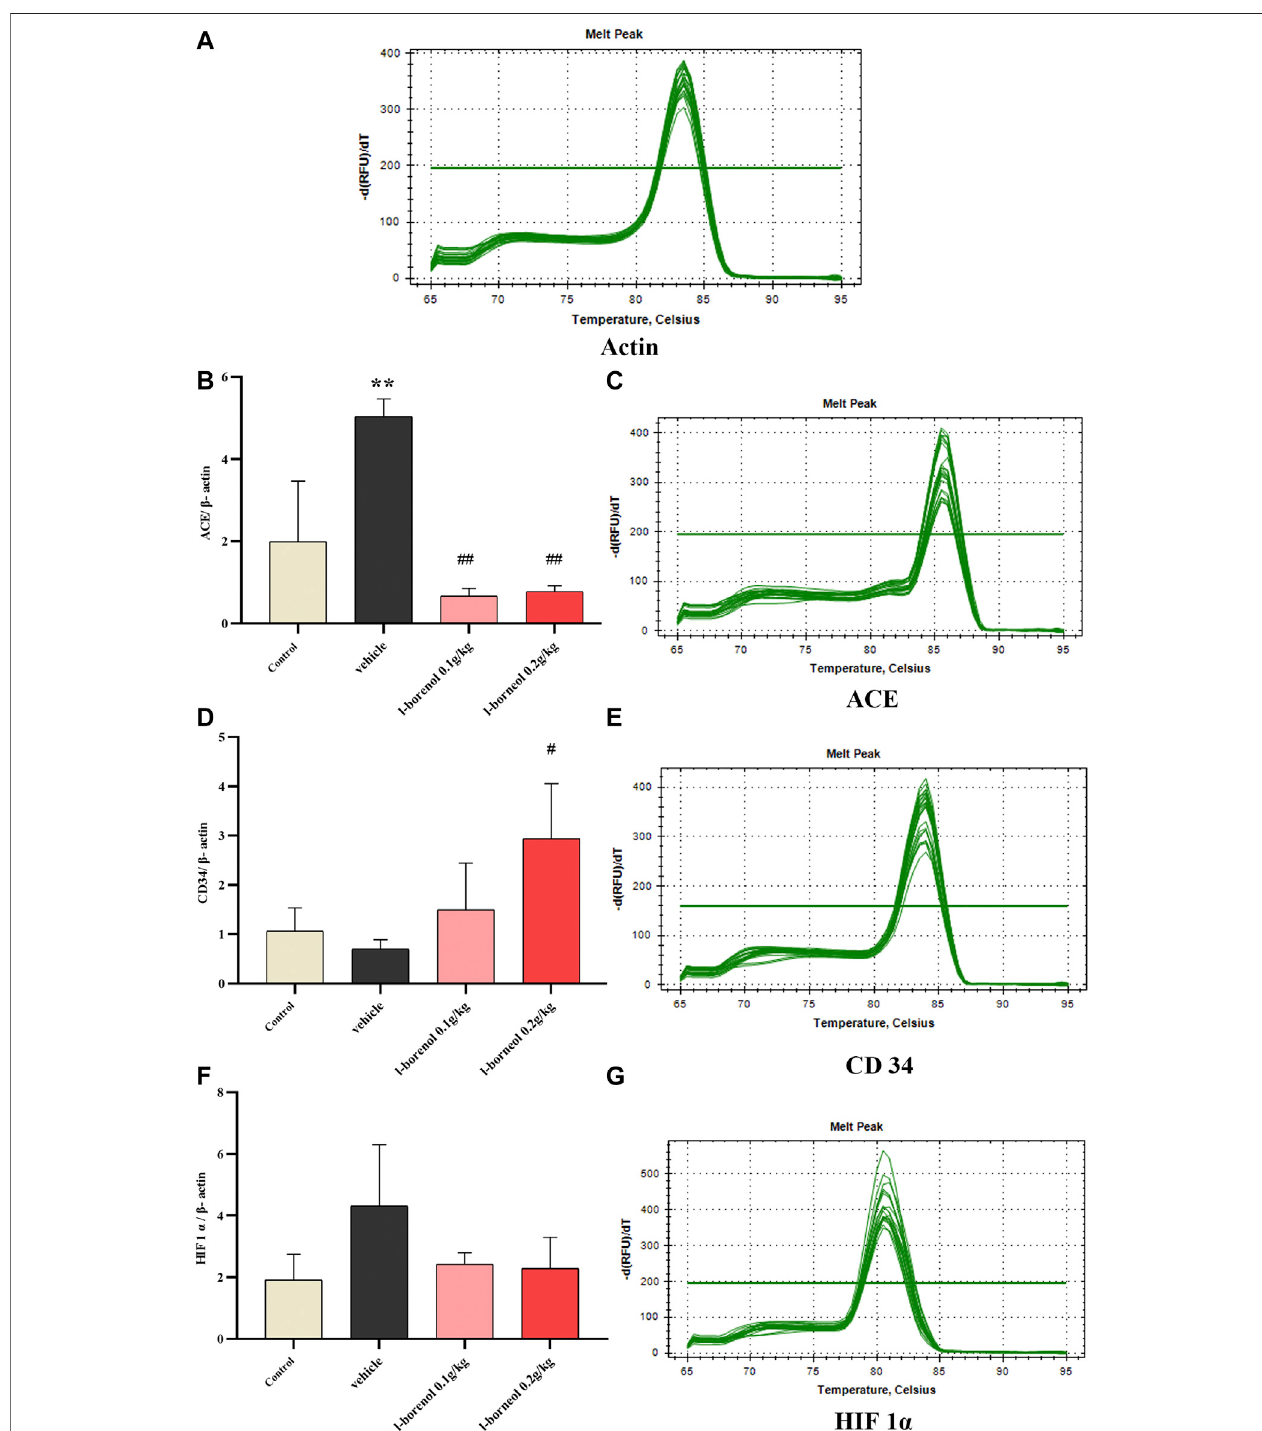
FIGURE7| IllustrationofACE,CD34,HIF1 α mRNAusingqRT-PCR( n (cid:2) 3). ** p < 0.01,comparedwiththecontrolgroup; # p < 0.05, ## p < 0.01,comparedwiththe vehicle